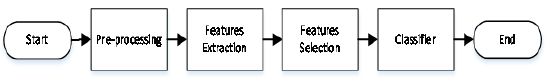
Figure 1. Structure of the Mania Speech Processing System.